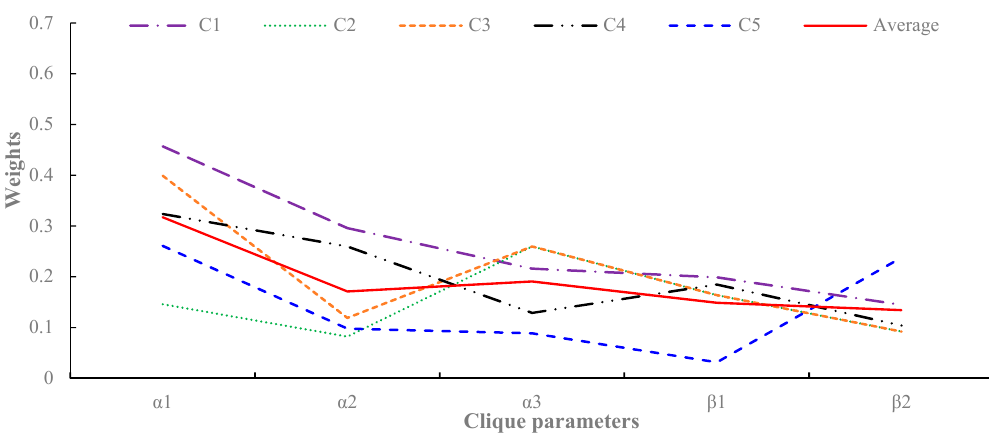
Figure 11. Estimations of the model parameters for the cliques in Figure 9.